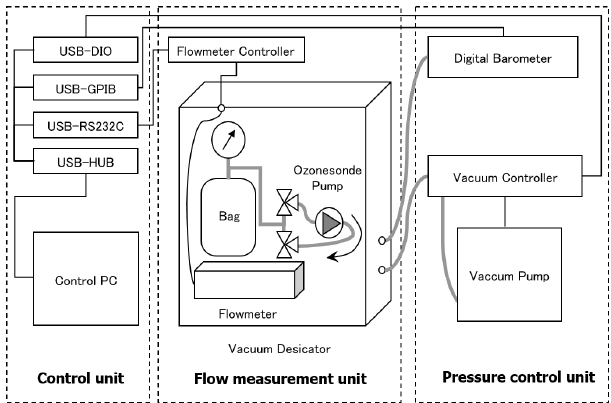
Figure 5. Schematic diagram of the flow measurement